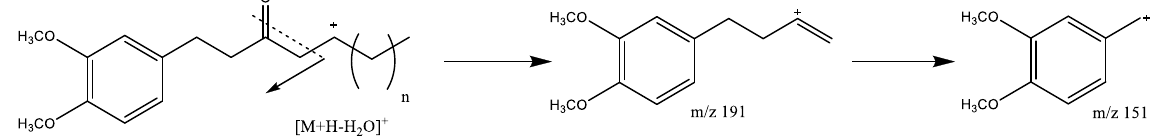
pattern similar to gingerols with fragments at m/z 191 and 151 (Figure 4) [11].